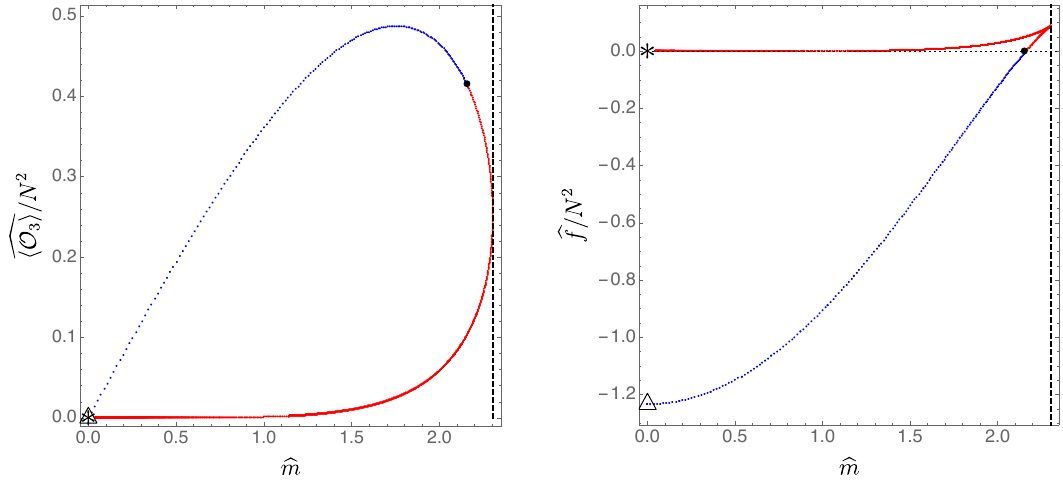
Figure 4 . Left panel: the vacuum expectation value h b O 3 i plotted as a function of panel: canonical ensemble phase diagram: conformally-invariant free energy b f as a function of the conformally-invariant mass deformation m . At m = m c (cid:24) 2 : 15 (the solution denoted with a black b b b disk (cid:15) with b f = 0), a (most likely (cid:12)rst-order) phase transition in the canonical ensemble occurs. Note that the (cid:3) solution (with (cid:26) = 0) has b f = 0, consistent with the claim that it describes b